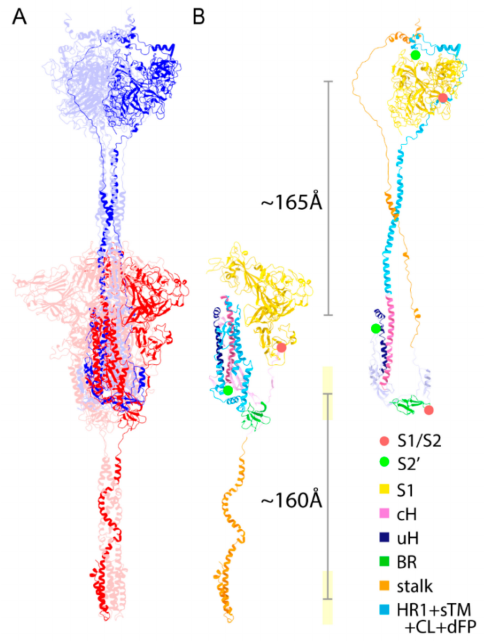
Figure 4. Structural comparison for a transition from the PRE state toward the POST state. ( A ) The structures of PRE (red) and POST (blue) states are shown. There are a few structurally maintained segments between PRE and POST states, including cH, BR, and uH. The figure is superimposed by the cH region. ( B ) A single monomer of the PRE and POST states (stalk: orange; BR: green; uH: dark blue; S1: yellow; cH: pink; HR1 + sTM + CL + dFP: light blue). The C α –C α distances between residues 685 and 686 (red dots) and between 815 and 816 (green dots) are ~250 and ~240 Å, respectively. The distances of S1 centers and transmembrane regions between fitted PRE and POST structures are ~165 and ~160 Å,